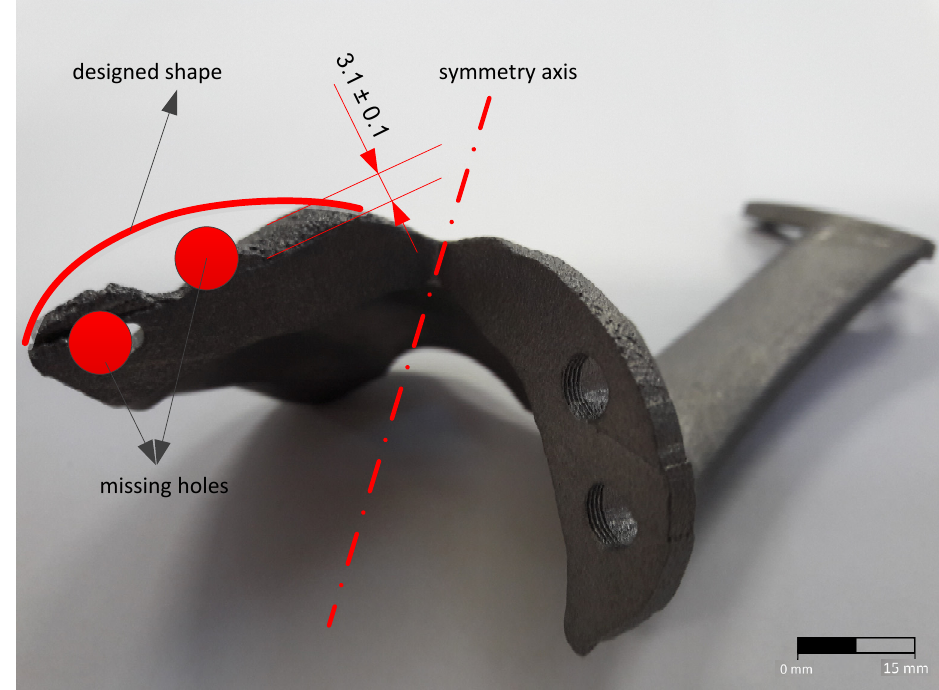
Figure 3. Custom implant obtained by the DMLS additive manufacturing process.